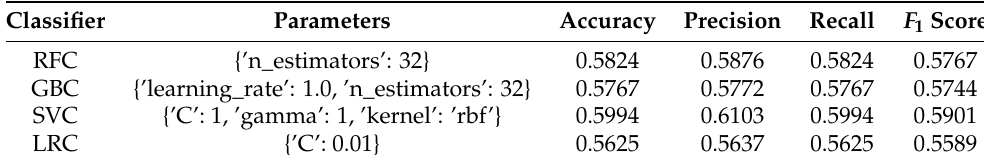
Table 10. Performance scores of the anxiety classifier using only activity tracking features on the training set.